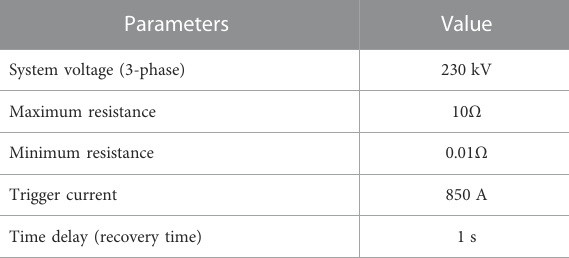
FIGURE 3 Single-phase model of SFCL.